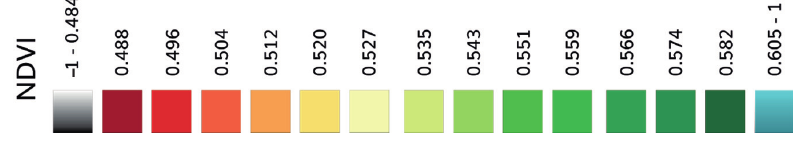
Figure 10. Look up table (colors